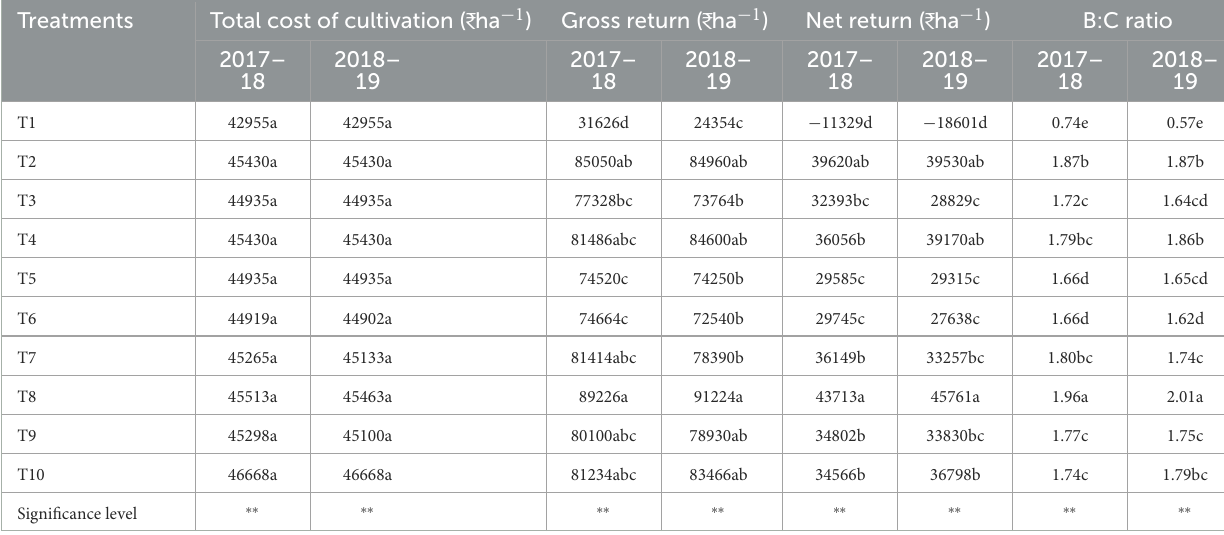
TABLE 5 Production economics of wheat as influenced by various nitrogen scheduling.